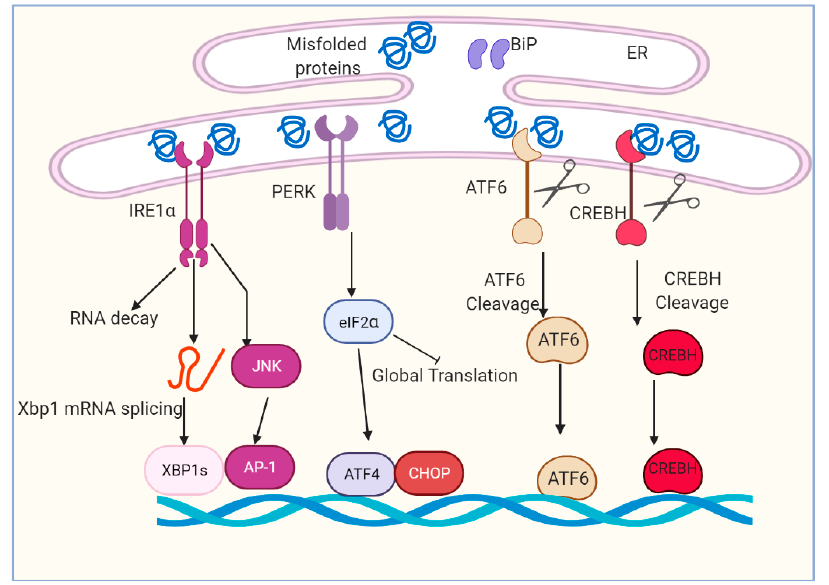
Figure 1. Overview of ER stress and unfolded protein response (UPR) signaling pathway. The accumulation of unfolded and/or misfolded protein induces ER stress and restores ER homeostasis. The cell activates a series of signaling pathways, named the unfolded protein response (UPR). The UPR is regulated by four main proteins: IRE1 α , PERK, ATF6 and CREBH. IRE1 α , PERK, ATF6 and CREBH are ultimately responsible for the activation of a set of transcription factors, including spliced Xbp1, ATF4, CHOP, cleaved ATF6 and cleaved CREBH.